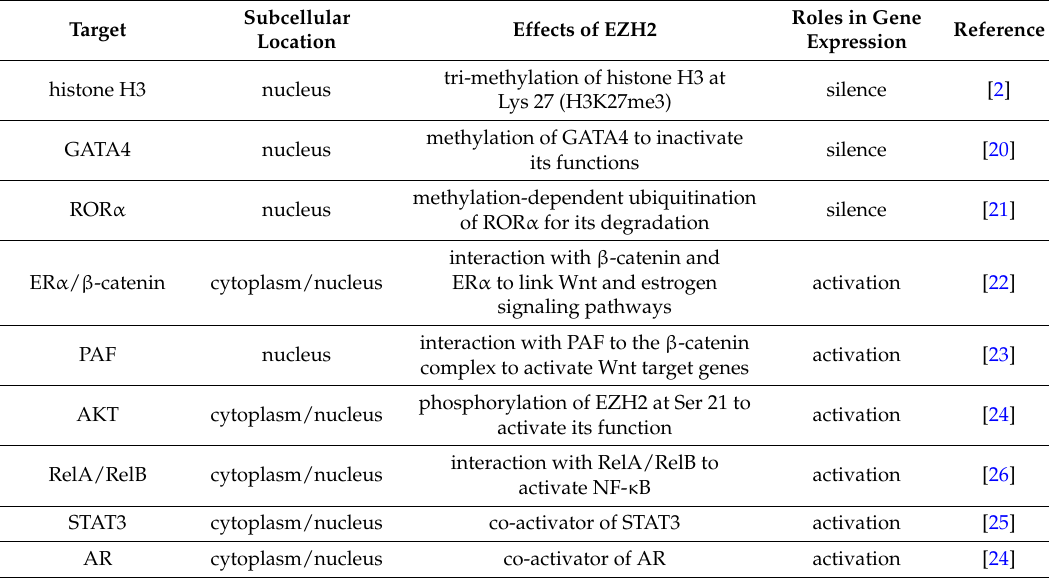
Table 1. EZH2 targets and their roles in gene